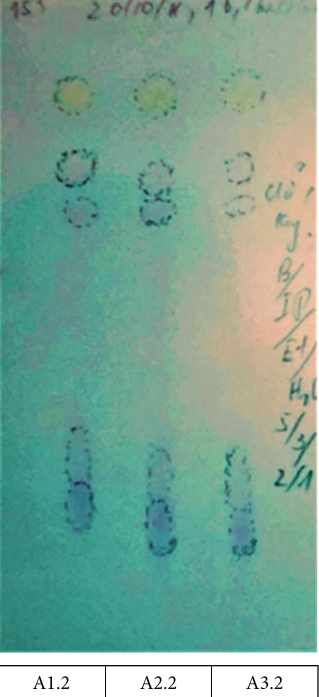
Figure 2: HPTLC of reference samples M1, M2, and M3 (50- month-old) developed in system A—butanol/isopropanol/ethanol/ water (5: 3:2:1 v/v).